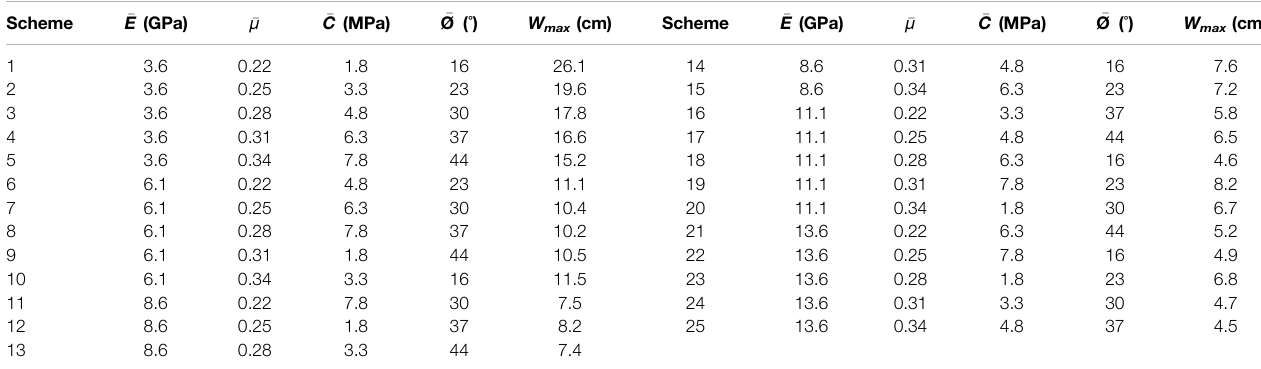
TABLE 3 | Orthogonal test design and results.